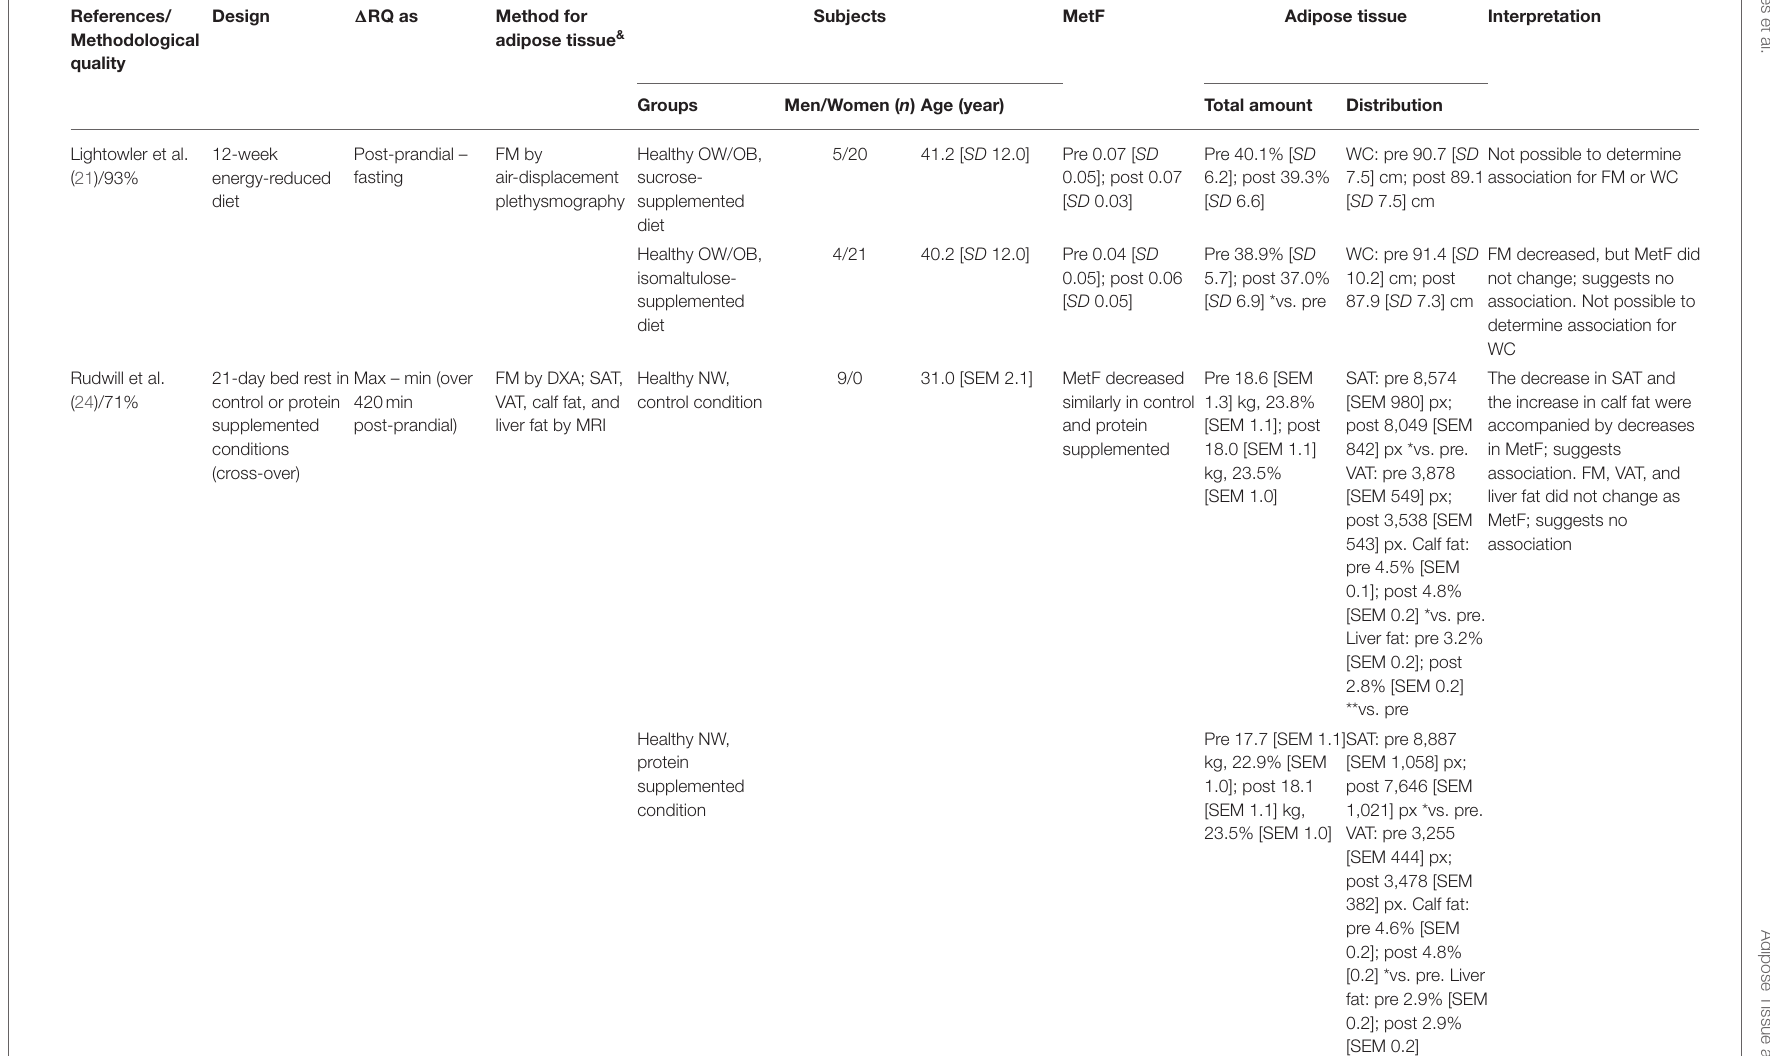
TABLE 2 | Summary of reports that measured MetF in response to dietary